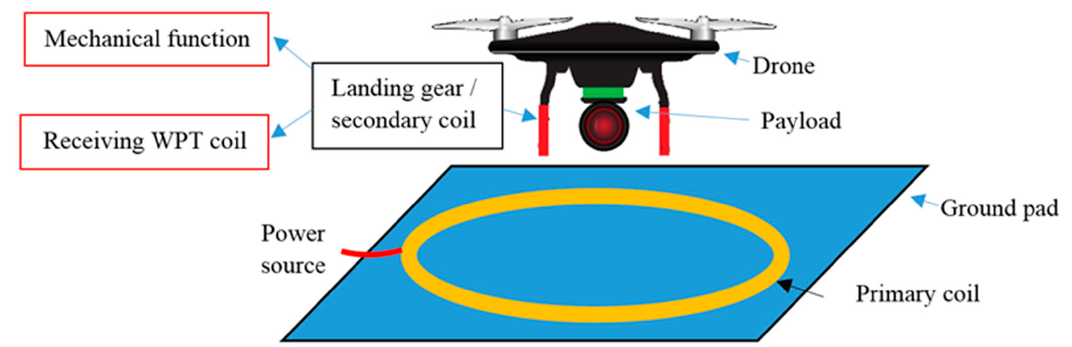
Figure 1. Sketch of the wireless power transfer (WPT) system for drone applications.